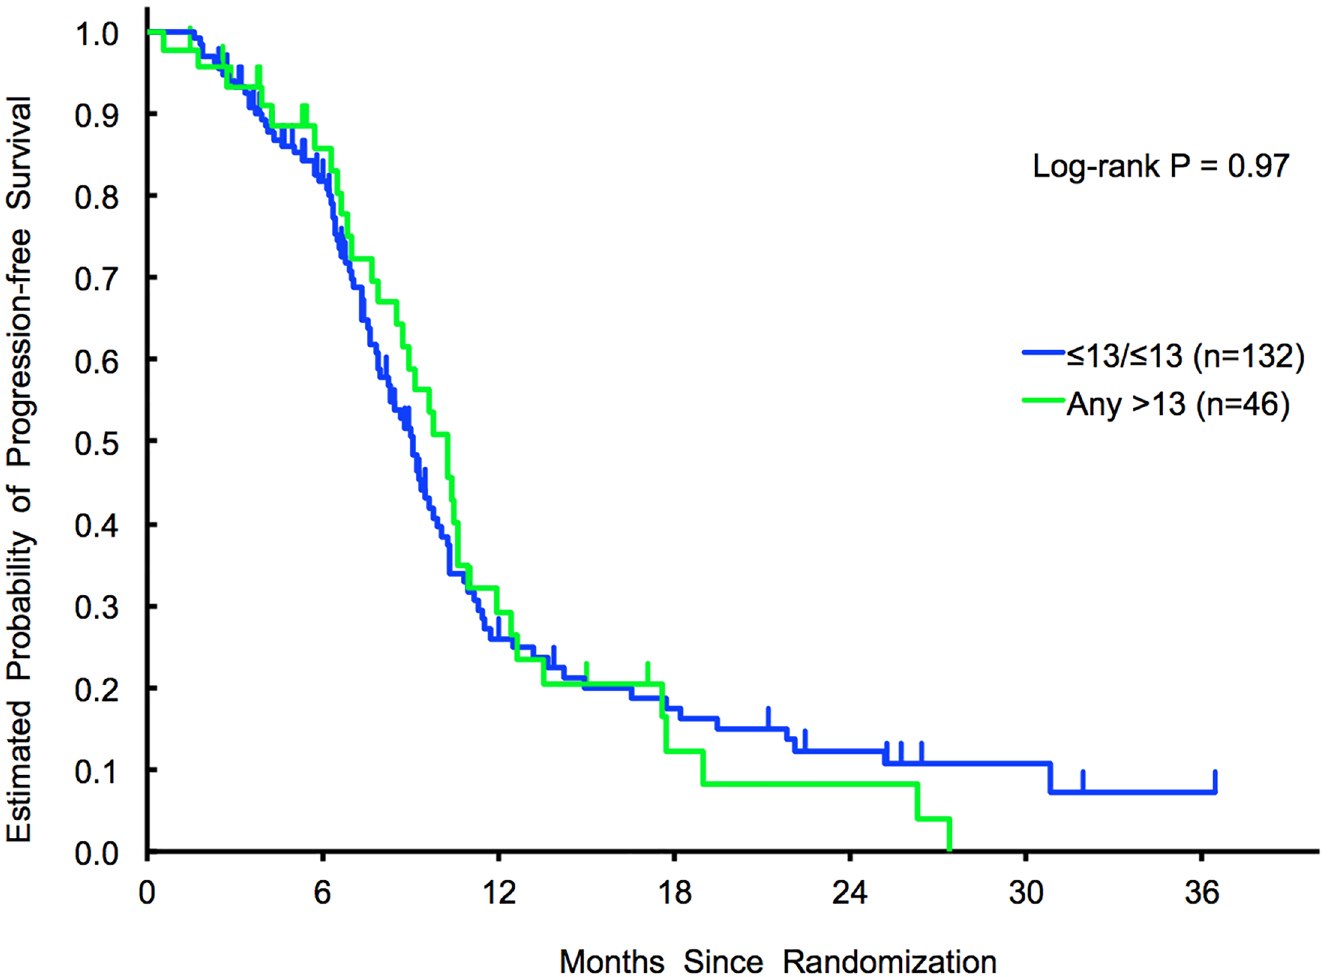
Fig 4. Validation cohort 2 (MOMA). PFS results in any > 13 repeats vs (cid:20) 13/ (cid:20) 13repeats